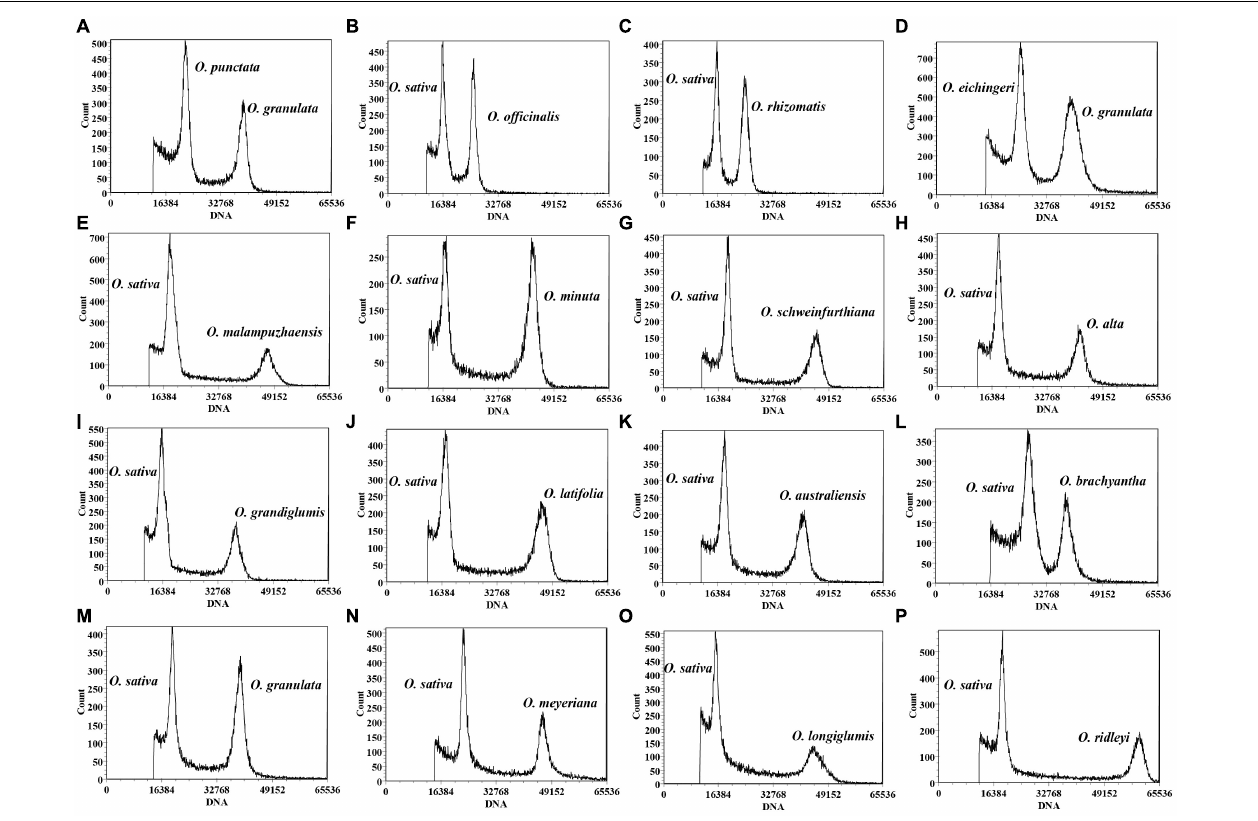
FIGURE 1 | Flow cytometry histograms of Oryza species. O. granulata was used as an internal standard for Oryza punctata (A) and Oryza eichingeri (D) . Oryza sativa L. ssp. japonica cv. Nipponbare (0.7955 pg/2C) was employed as internal standard for Oryza officinalis (B) , Oryza rhizomatis (C) , Oryza malampuzhaensis (E) , Oryza minuta (F) , Oryza schweinfurthiana (G) , Oryza alta (H) , Oryza grandiglumis (I) , Oryza latifolia (J) , Oryza australiensis (K) , Oryza brachyantha (L) , Oryza granulata (M) , Oryza meyeriana (N) , Oryza longiglumis (O) , and Oryza ridleyi (P)